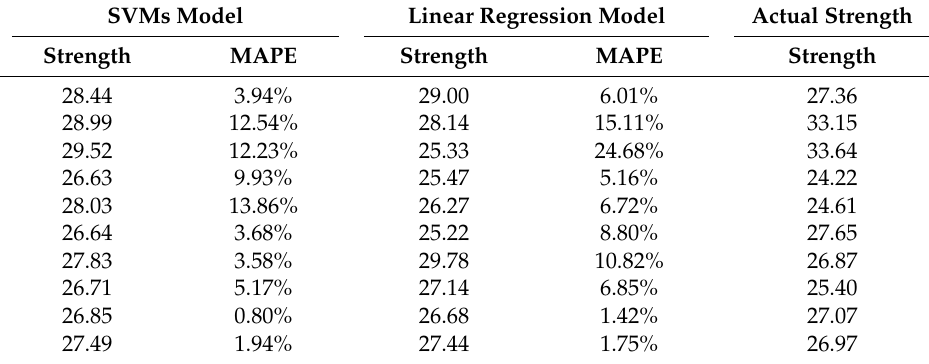
Table 2. SVMs and linear regression model